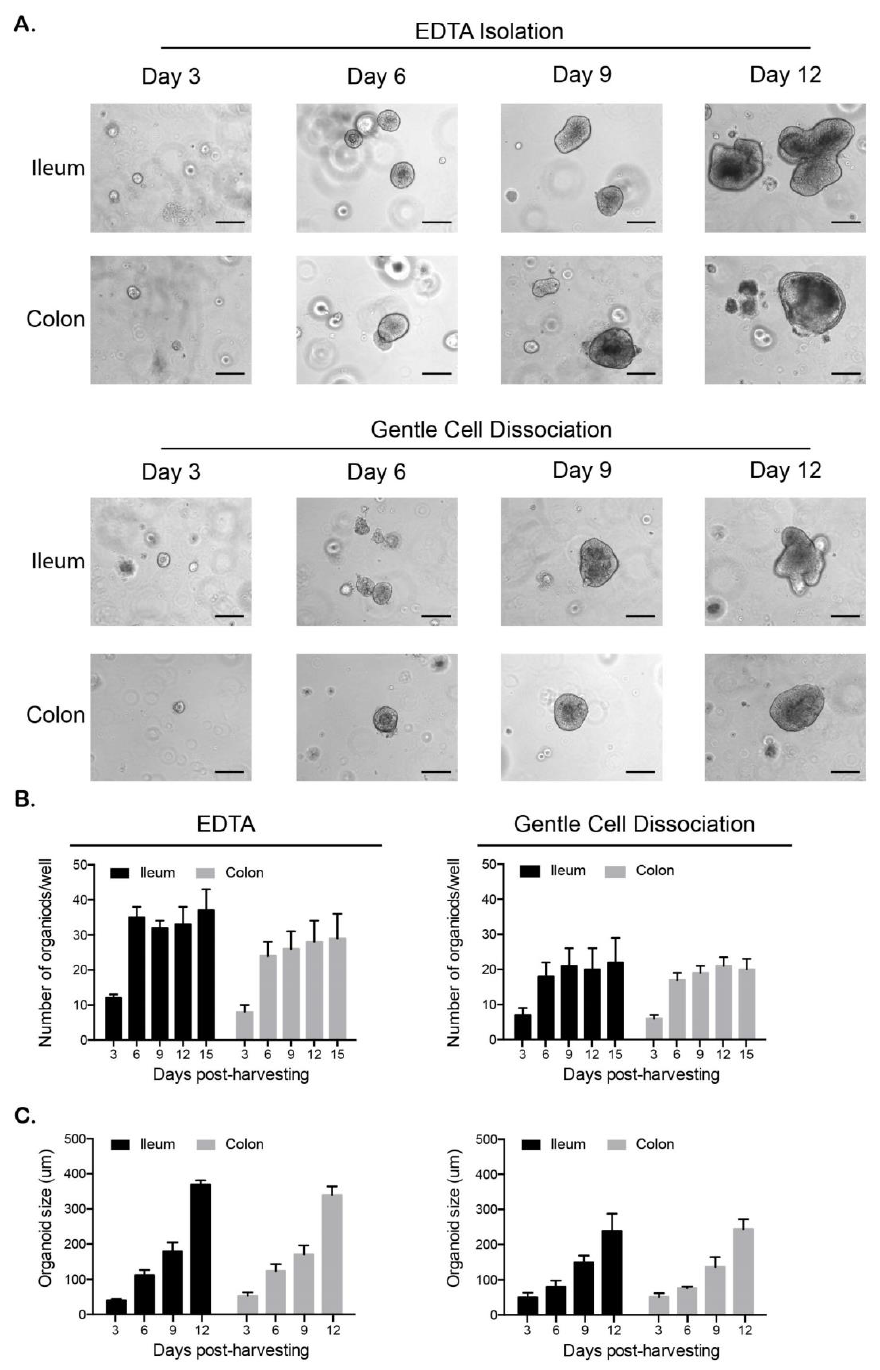
Figure 1. Ileum and colon organoids can be established from primary feline tissue. ( A – C ). The 1 cm 2 sections of feline ileum and colon tissue were incubated with EDTA or Gentle Cell Dissociation Reagent to allow for the isolation of intestinal crypts. Isolated crypts were resuspended in Matrigel and followed over a 12-day period. ( A ). Bright field images of ileum and colon organoids. Representative images are shown (n = 6 donors). Scale bar = 100 µm. ( B ). The number of organoids from EDTA and Gentle cell Dissociation Reagent isolation were counted over the indicated time course. Error bars represent standard deviation (n = 6 donors). ( C ). Following EDTA and Gentle cell Dissociation Reagent isolation, organoids were imaged in three-day intervals using a Nikon Eclipse Ti-S. Their size was measured using the Nikon NIS software. Error bars represent standard deviation (n = 6